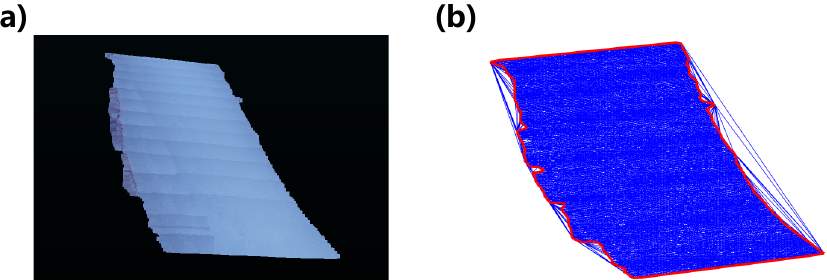
Figure 10. The first group of data-processing results for the Zhangjiakou Wanlong Ski Resort (Param- eters: T = 1.2 cm, A = 0.7, D = 43 cm): ( a ) color point cloud; ( b ) ski-track boundary extraction.